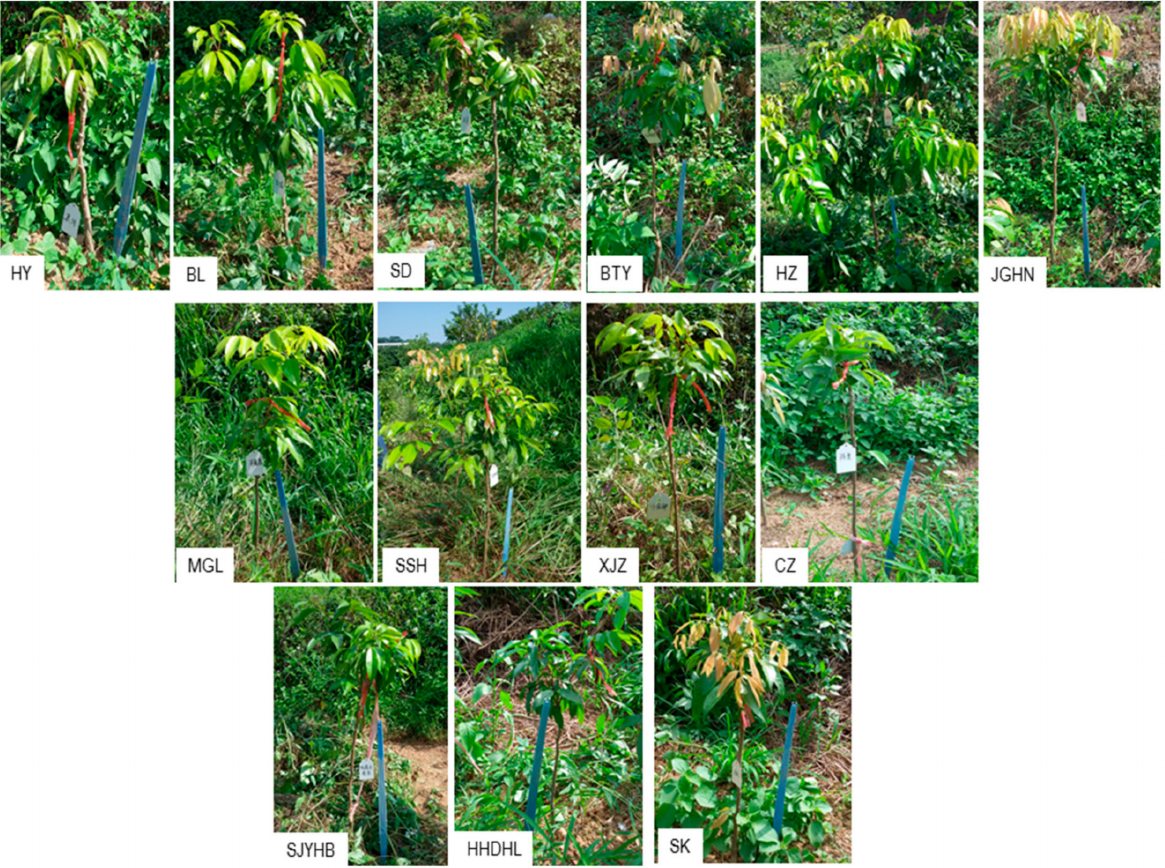
Figure 1. Morphology of ‘Lingfengnuo’ grafted onto seedlings of different